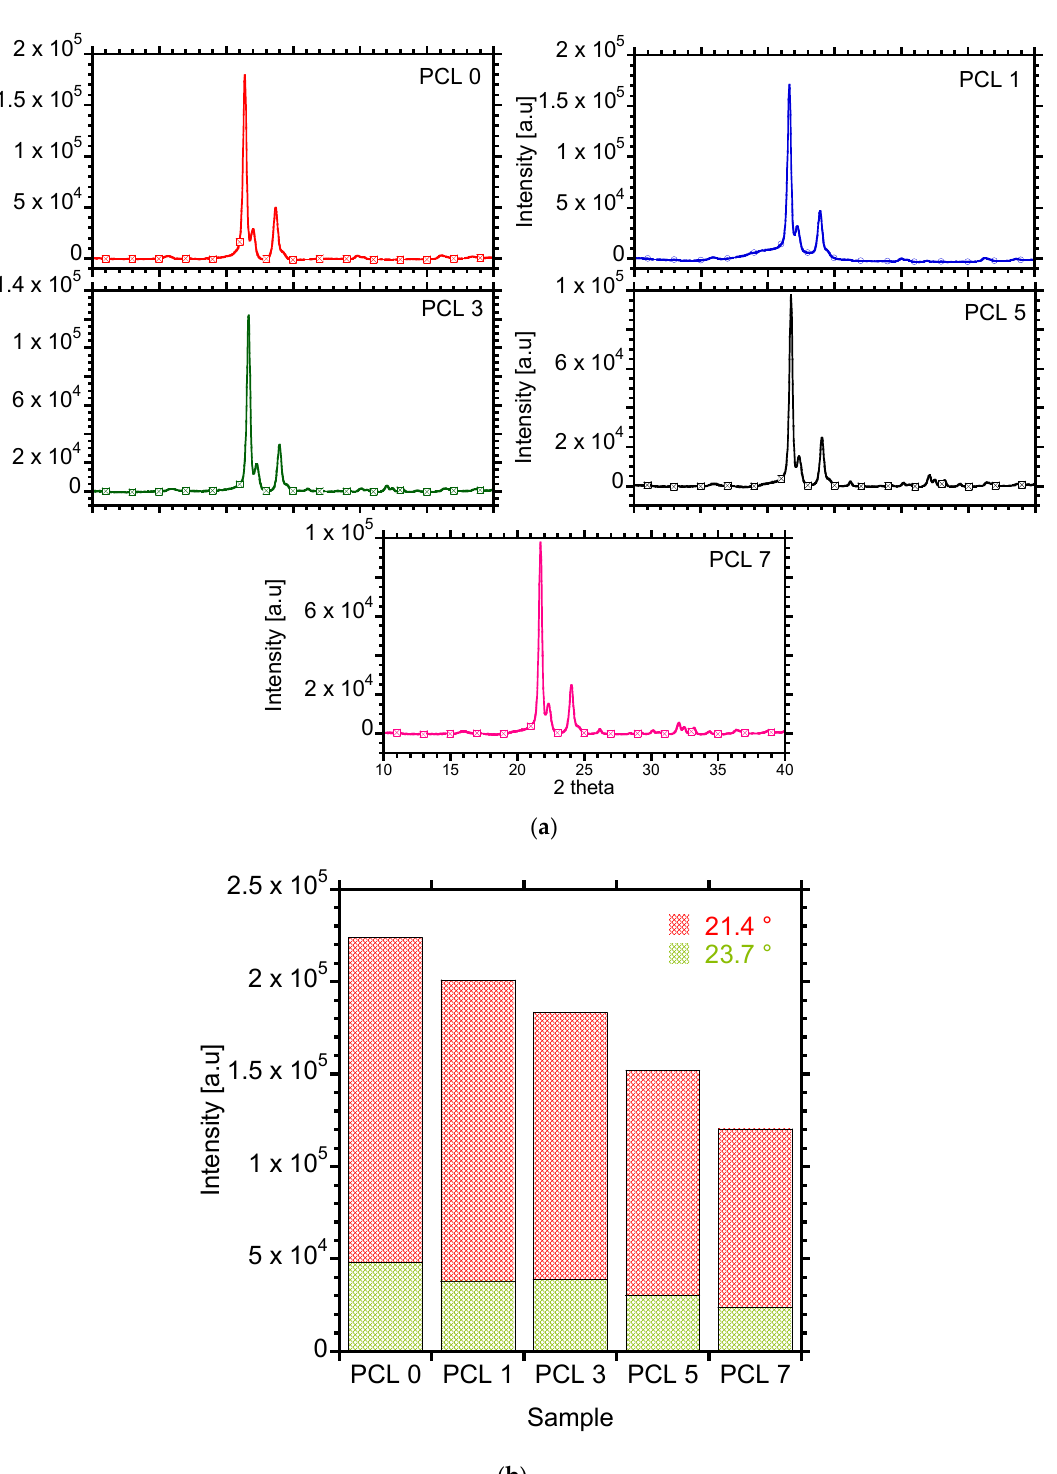
Figure 7. ( a ) XRD diffraction patterns with corrected baseline. ( b ) Change in intensity of (110) and (200) planes as a function of HAP concentration.